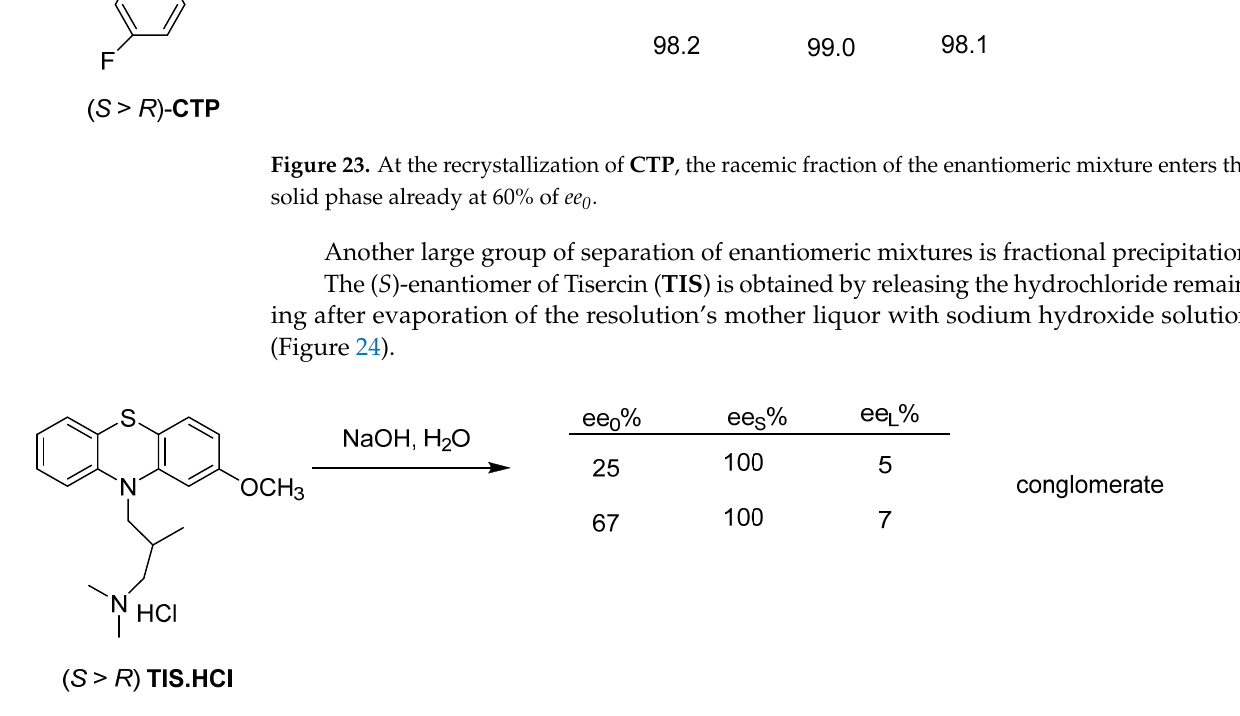
Figure 24. During the release of the base, the enantiomeric excess of the mixture enters the solid phase and the almost racemic fraction remains in the mother liquor.